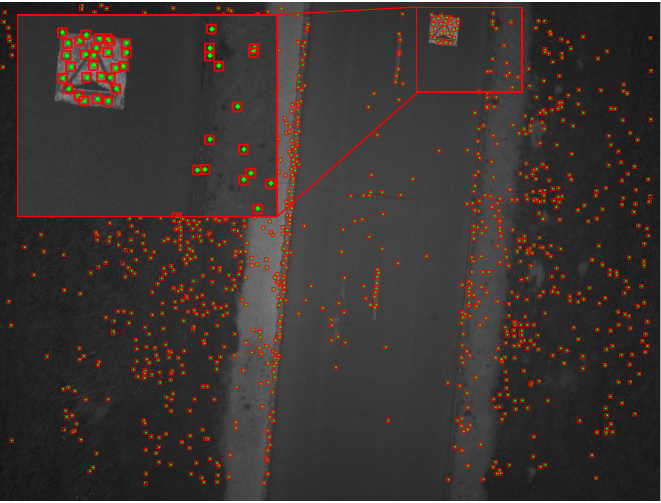
Figure 12. Search areas obtained by the IMU gyrometers between the first image and the 10th image. The green points represent the homologous points obtained by template matching. The size of each search area is 11 × 11 pixels; image resolution: 2560 × 1920